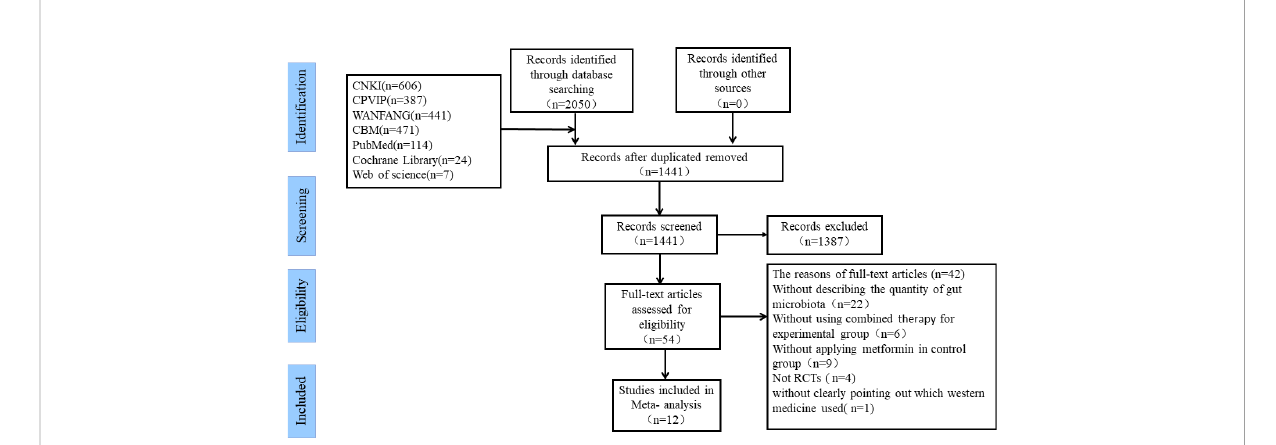
FIGURE 1 The inclusion and exclusion